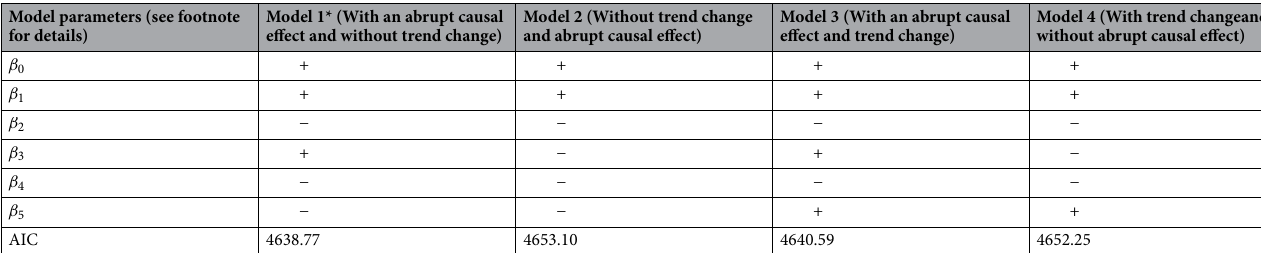
Table 1. Comparison of models that capture the time-dependent variations in the case fatality risk of COVID- 19 in Japan. Plus shows what was accounted for, and minus that this was not included in that model. β 0 is the parameter for the baseline level; β 1 , the increase in the outcome following the time-unit increase; β 2 and β 3 , the change in the level at first and second interventions (7 April and 8 May 2020, respectively); and β 4 and β 5 , the change in trend following first and second interventions (7 April and 8 May 2020, respectively).